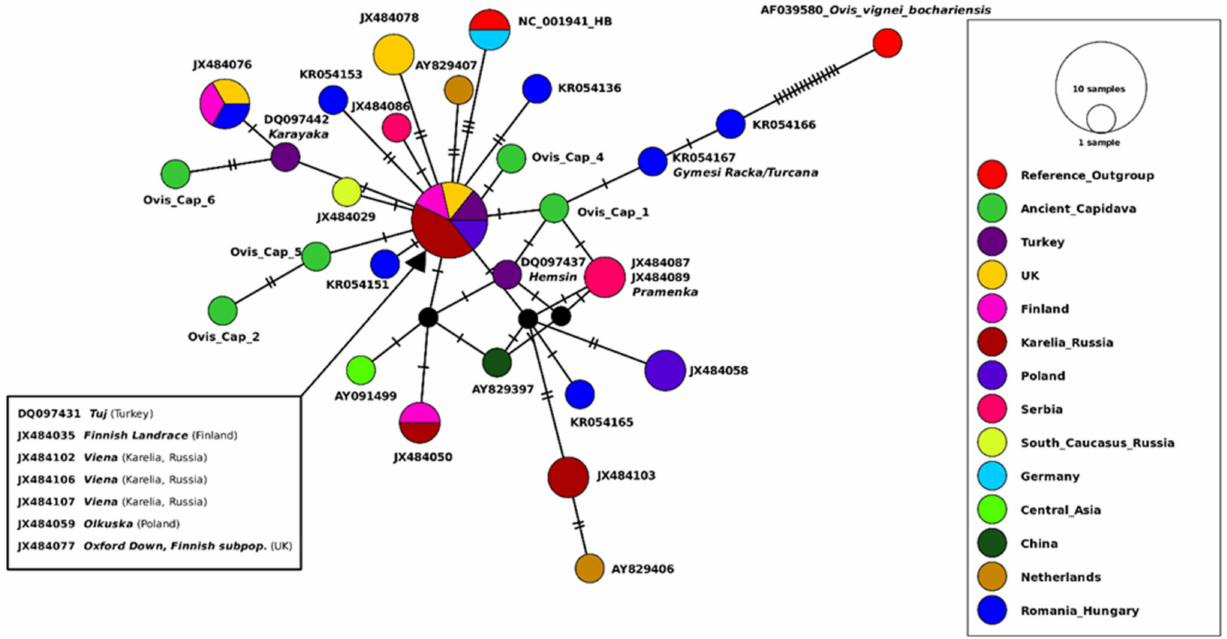
Figure 4. Median Joining Network illustrating the degree of haplotype similarity between the Capidava cohort and 37 sequences representing various modern breeds originating from different countries. The analysis was performed on a 474 bp region, nucleotide positions 16027 to 16500 (NC_001941). Node size is proportional to the number of sequences, as indicated in the figure legend. Cross lines represent the number of mutations. Branch length is not